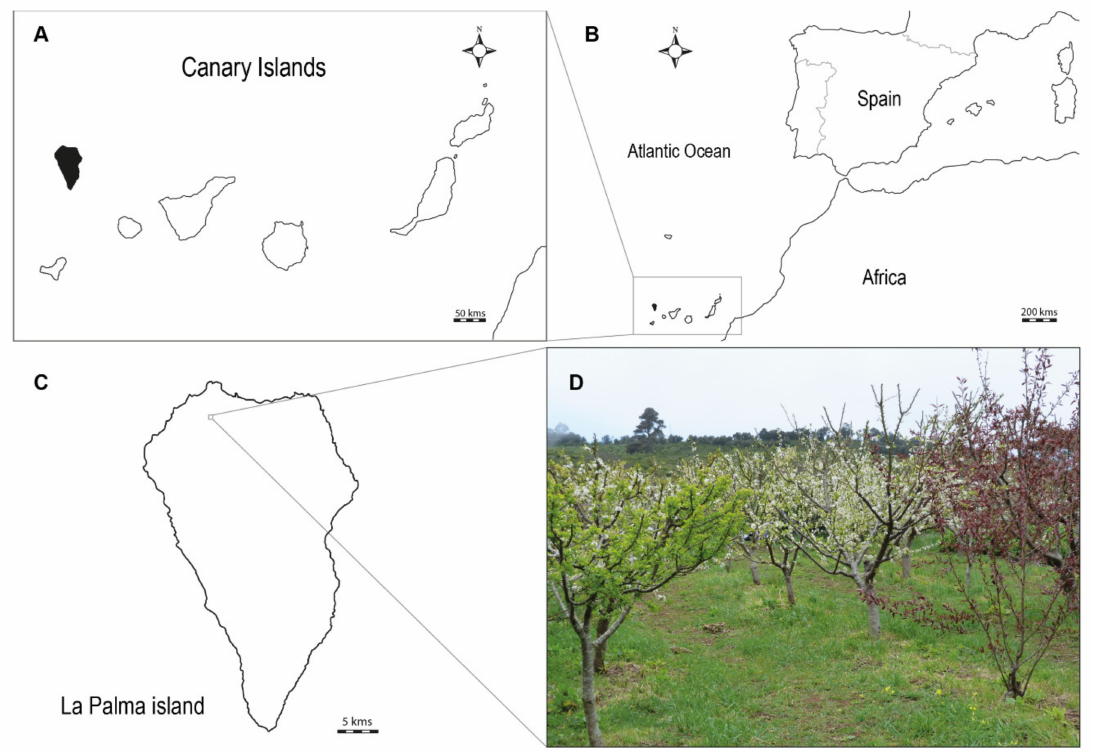
Figure 1. ( A , B ) Location of La Palma within the Canary Islands and in relation to mainland Spain; ( C ) location of Granja Experimental de Garaf í a-Cabildo Insular de La Palma plum collection; ( D ) pho- tography of La Palma plum collection during the blooming